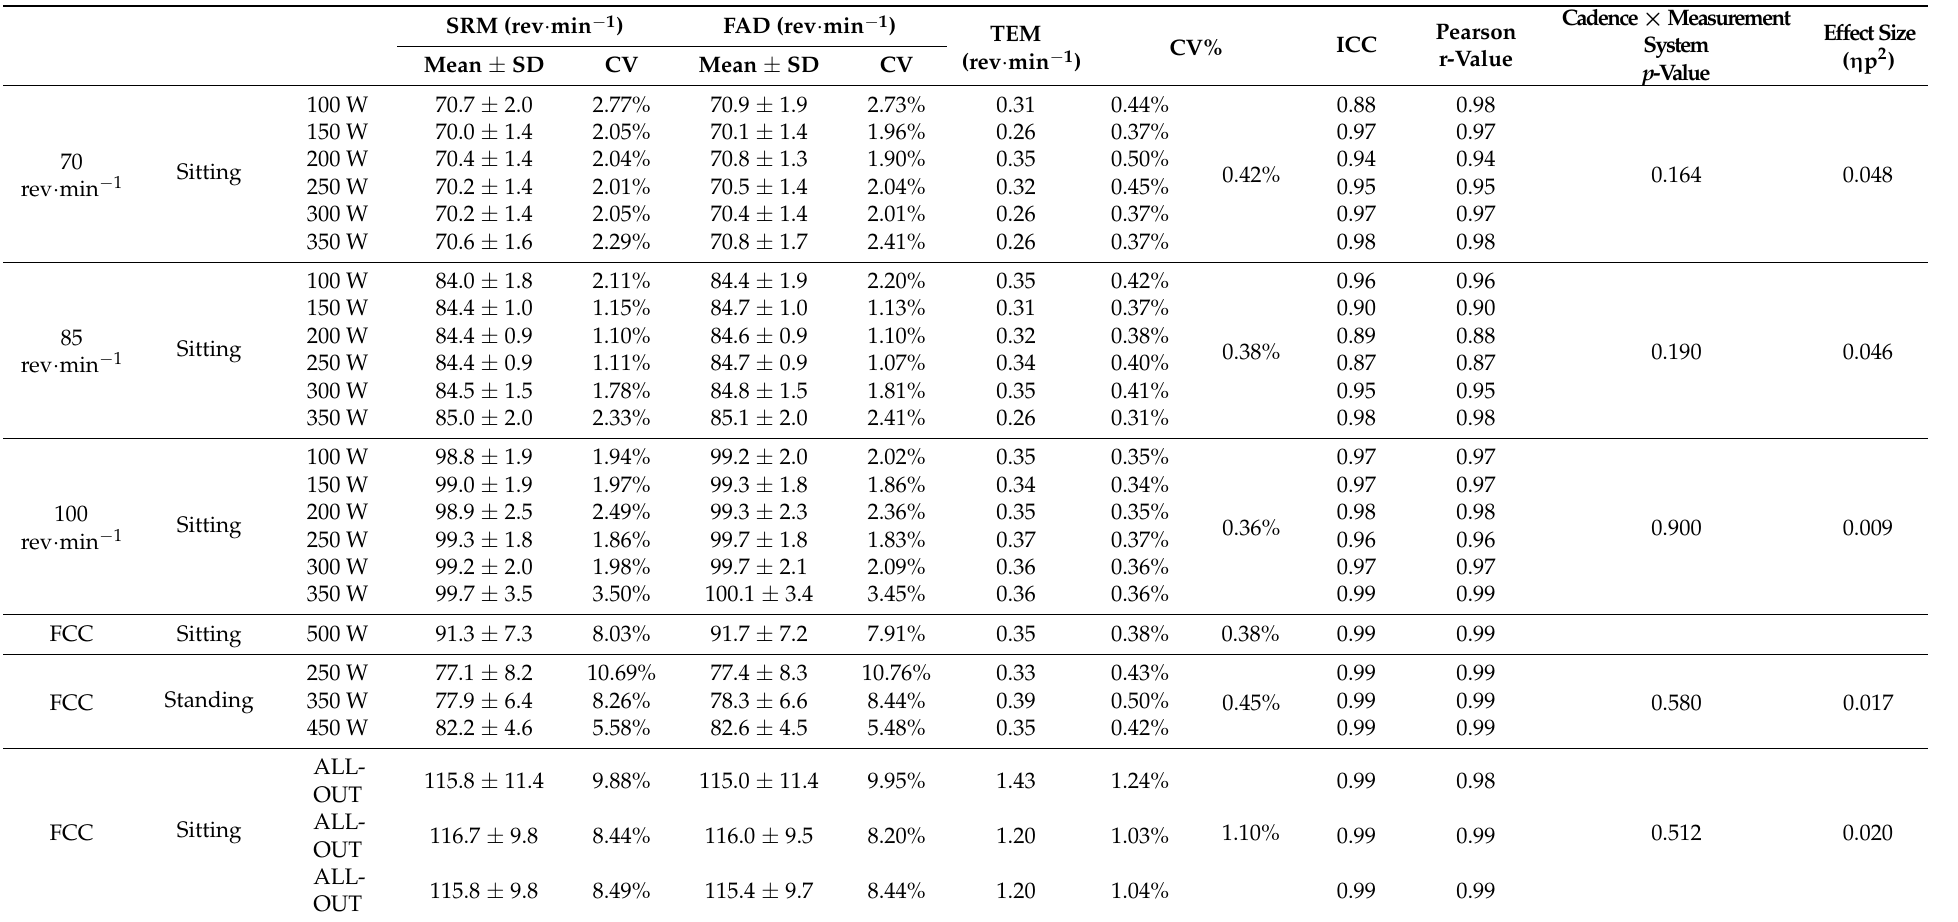
Table 3. Analysis of the mean cadence registered by the SRM and the FAD power